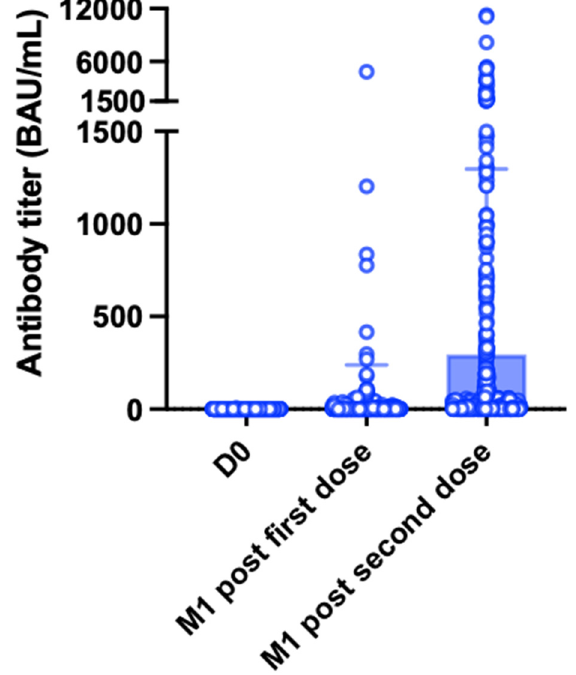
Figure 3. Antibody titer over time. Assessments were performed on the vaccination day (D0, n = 562), one month (M1) after the first dose, and one month after the second dose ( n = 562). White dots represent individual values, whereas blue bars and the black lines indicate the means and standard deviations, respectively. After the second dose, antibody titers increased significantly from 20.7 ± Table 3. Variables included in the score for predicting serological response to Table 2. Univariate and multivariate analysis of predictors factors for seroconversion after two vac- cine doses.